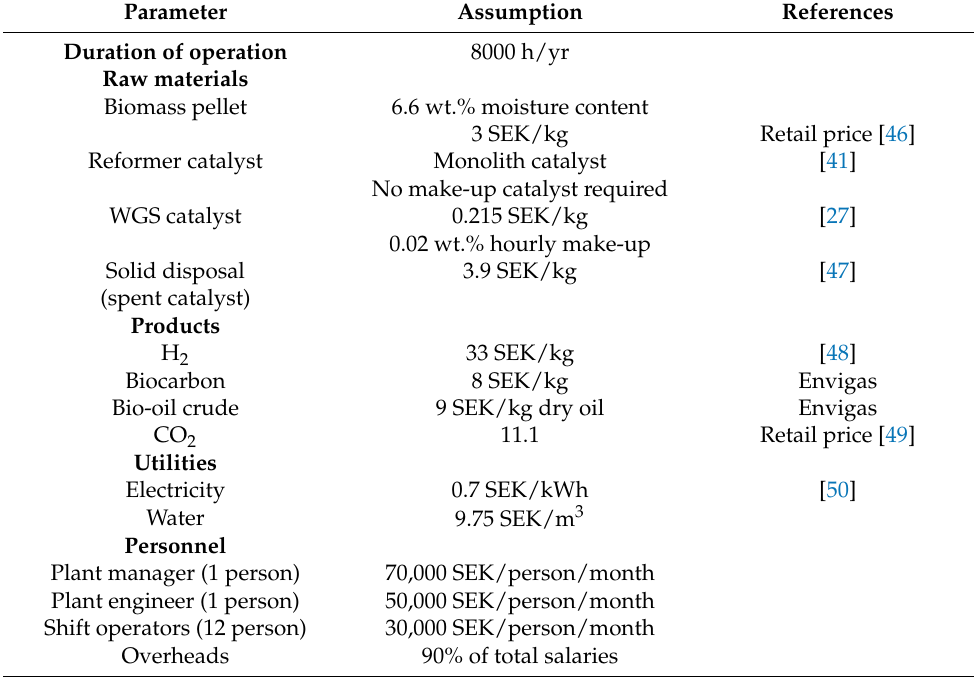
Table 9. The assumption for the OPEX calculation.